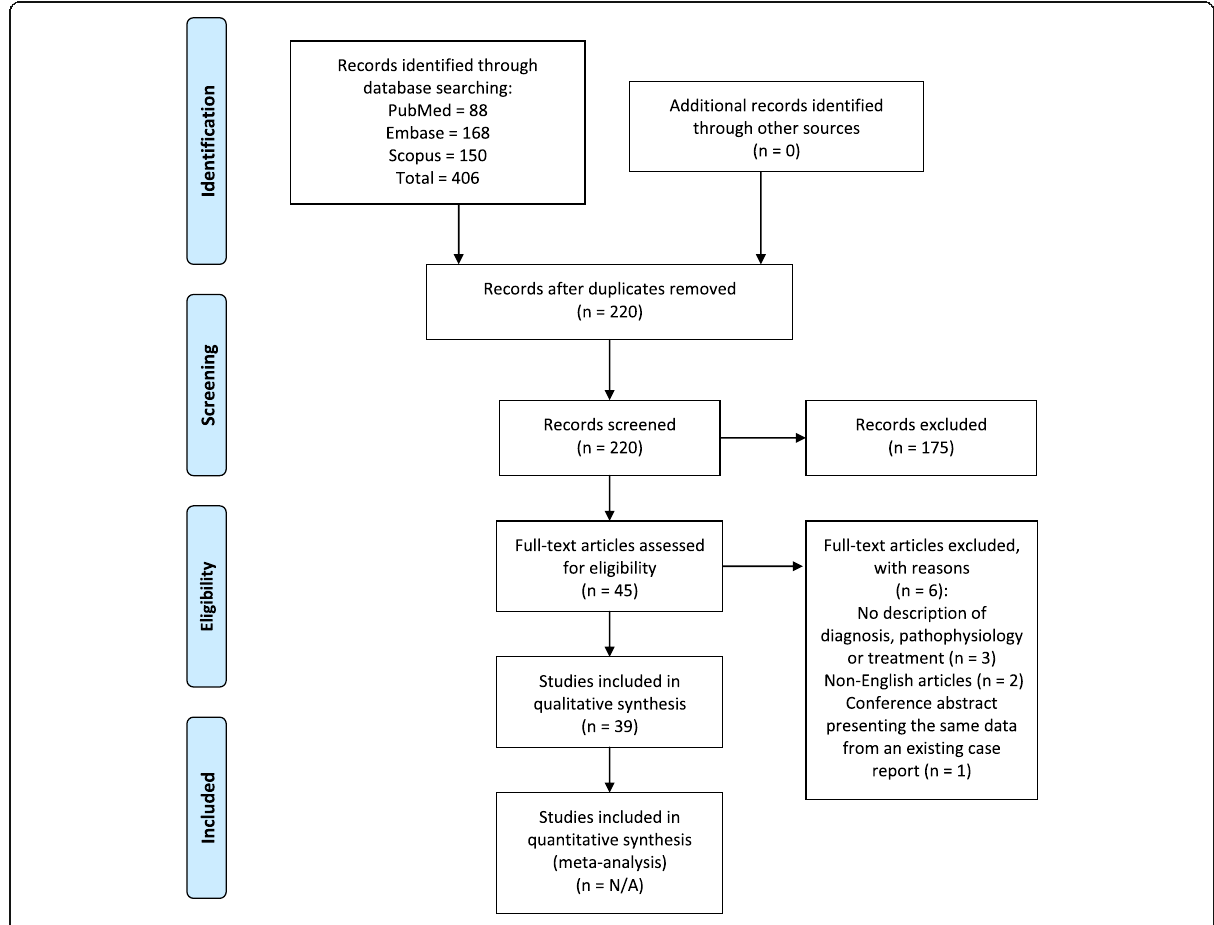
Fig. 1 PRISMA flowchart for the selection of